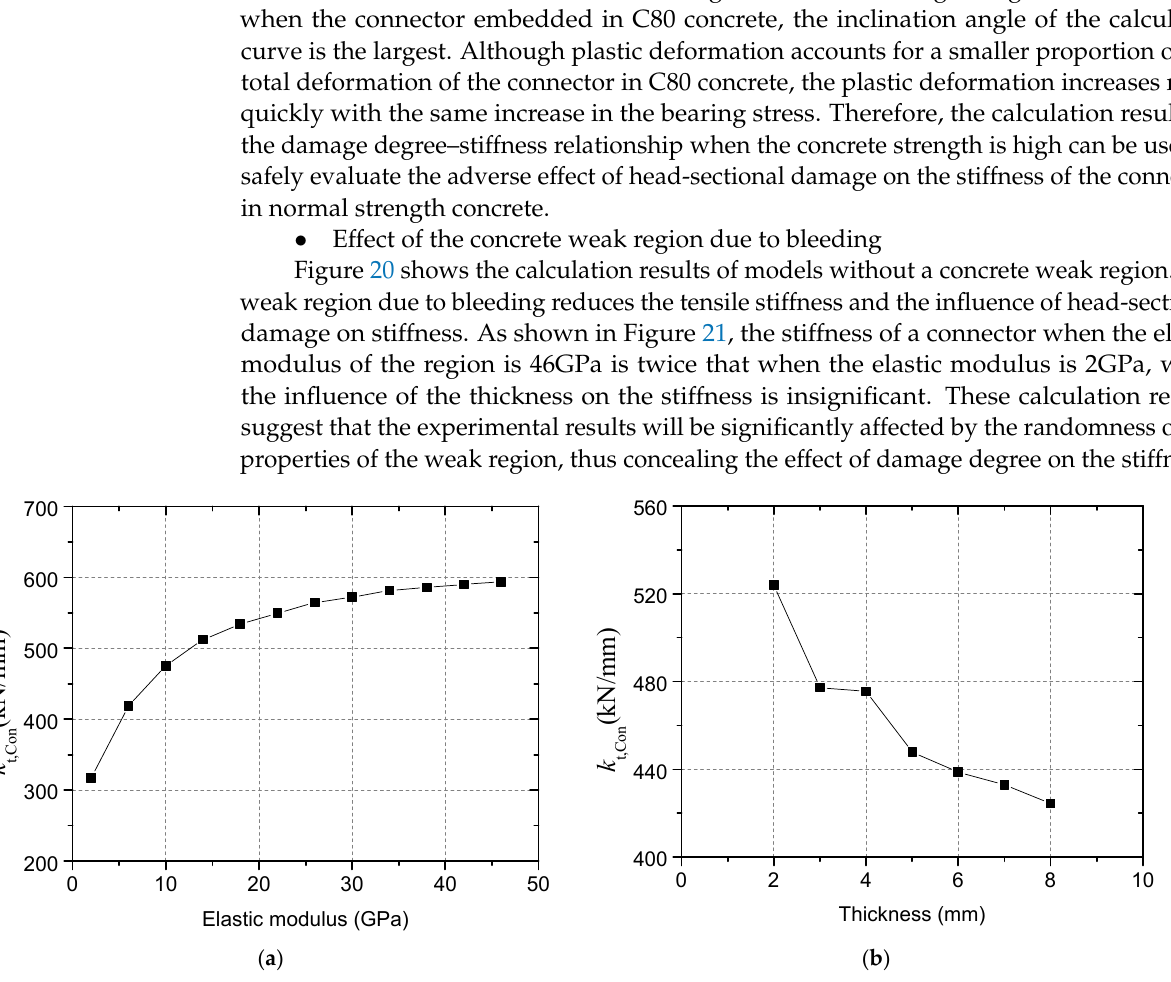
Elastic modulus (GPa)